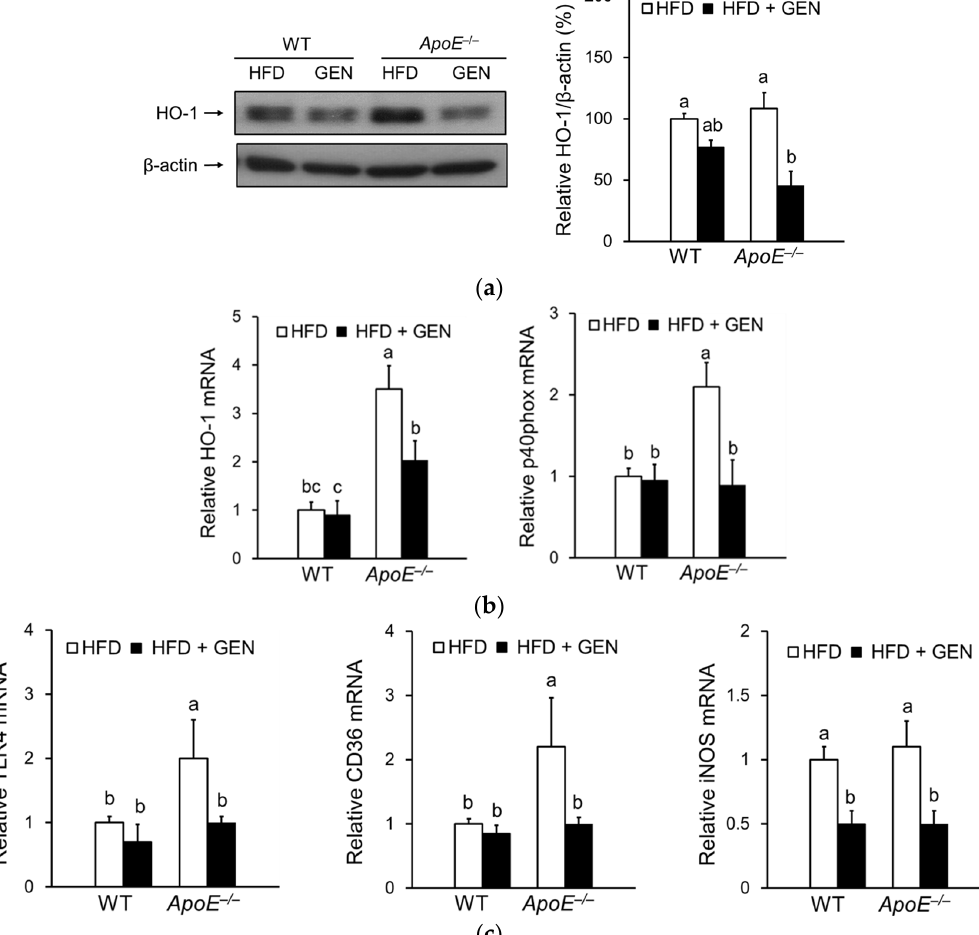
Figure 4. Effects of genistein on oxidative stress and inflammation in the cortex and hippocampus of WT and ApoE − / − mice fed an HFD. ( a ) Relative protein levels of HO ‐ 1 were analyzed by immunoblotting and were normalized to beta ‐ actin ( n = 3); ( b ) relative mRNA expressions of genes involved in oxidative stress, HO ‐ 1 and p40phox, were analyzed by real ‐ time PCR and normalized to ribosomal protein L19 (RPL19) ( n = 4–5); ( c ) relative mRNA expressions of genes involved in inflammation, TLR4, CD36, and, iNOS were analyzed by real ‐ time PCR and normalized to RPL19 ( n = 4–5). Each bar represents the mean ± SEM and bars with different superscripts are significantly different at p < 0.05.